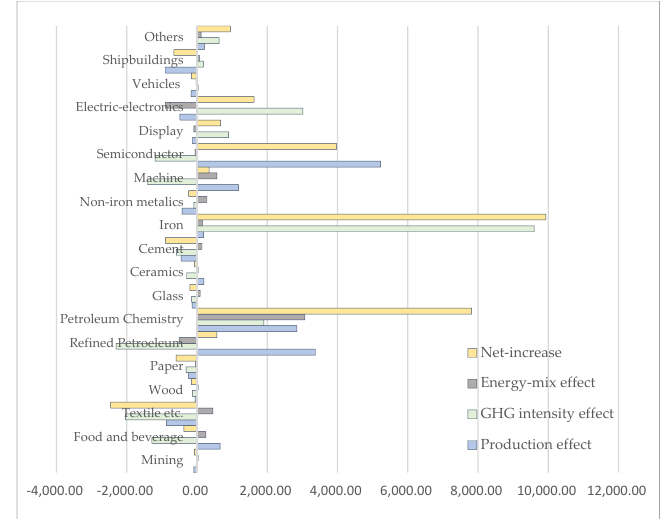
Figure 1. Decomposition results of LMDI.